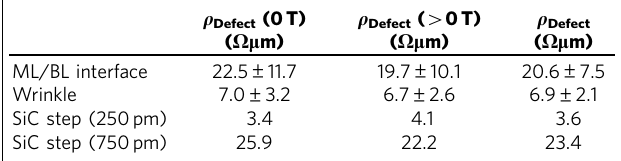
Table 1 | Results for the conductivity r , charge carrier concentration n e and mobility l for macroscopic averaged measurements as well as MLG and BLG with their respective s.d.’s Dr and D n e .